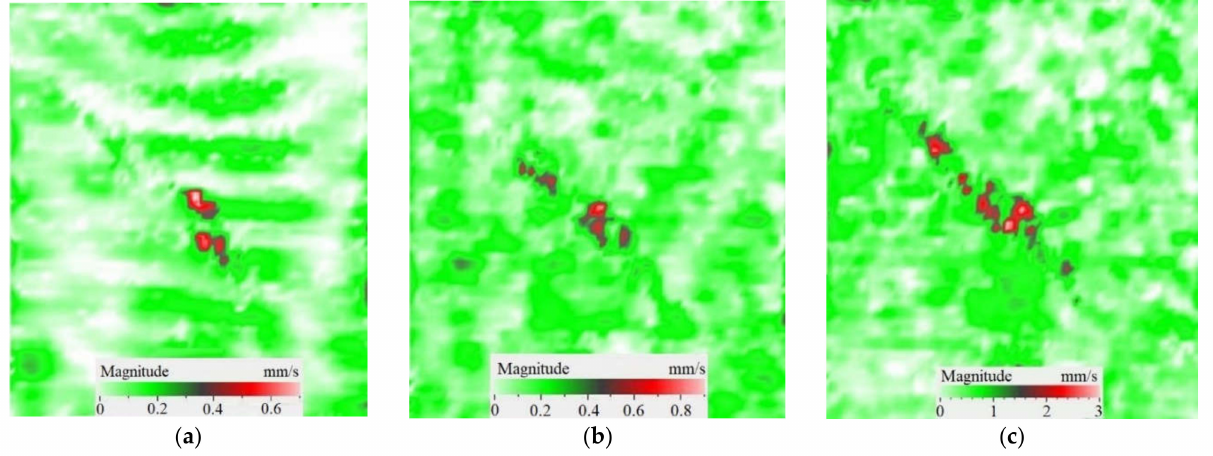
Figure 8. Total pattern of resonance vibrations on rear surface of CFRP sample with 18 J impact damage: ( a )-7.44 kHz, ( b )-32.8 kHz, ( c )-46.5 kHz.